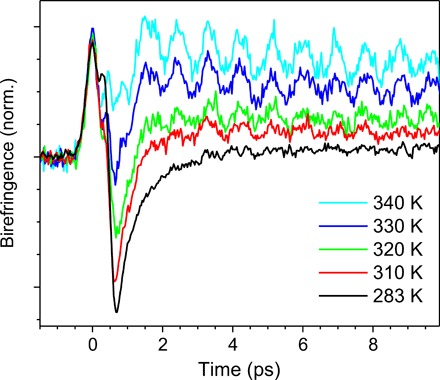
Dynamic Kerr effect of water.In a vertical configuration, the THz pump and optical probe pulses propagate into a top-open bucket of water. The ratio of vapor to liquid in the path of the two beams varies by temperature. The vapor (liquid) signal is dominant at higher (lower) temperatures. The strong oscillations indicate single-molecule coherent rotational motion of water vapor. A remarkable effect, pertinent to the current study, is the bipolar TKE signal of liquid water.